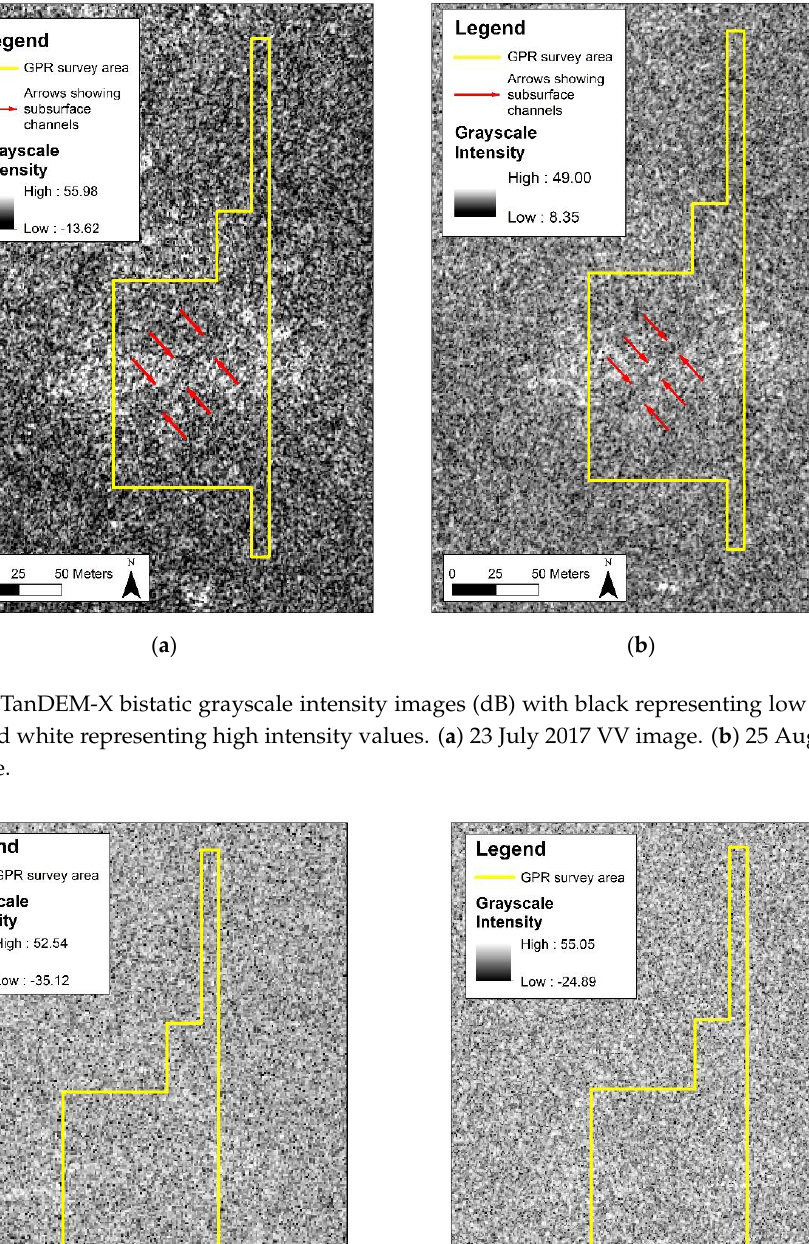
Figure 4. TanDEM-X bistatic image coregistered stacks (grayscale intensity images processed with Gray Level Co-occurrence Matrix ((GLCM)) variance texture analysis), with black representing low intensity values and white representing high intensity values. ( a ) Summed stack of 10 VV images. ( b ) Summed stack of 6 HH images.